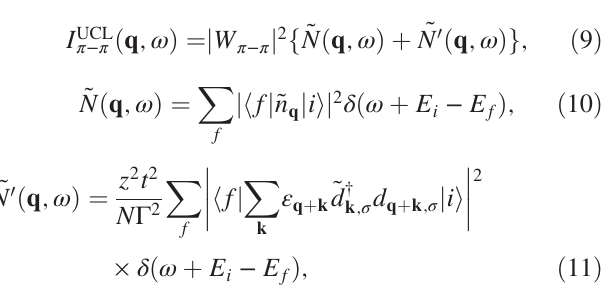
FIG. 3. Momentum and energy integrated spectral weight R 1 . 6 t ω Þ d ω and the various for full RIXS 0 I ð